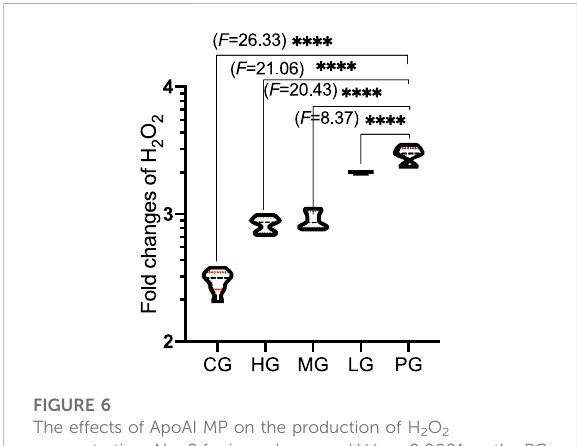
FIGURE 6 The effects of ApoAI MP on the production of H 2 O 2 concentration. N = 8 for in each group. **** p < 0.0001 vs. the PG